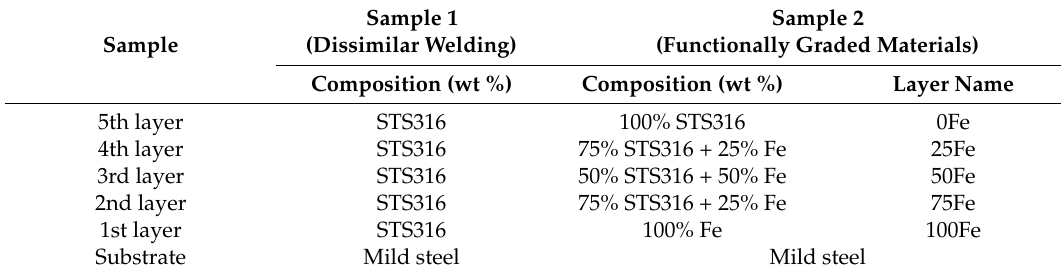
Table 3. Deposition sequence used in this study.